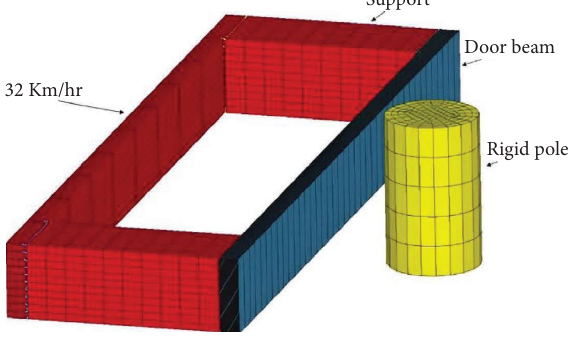
Figure 9: Side pole test.